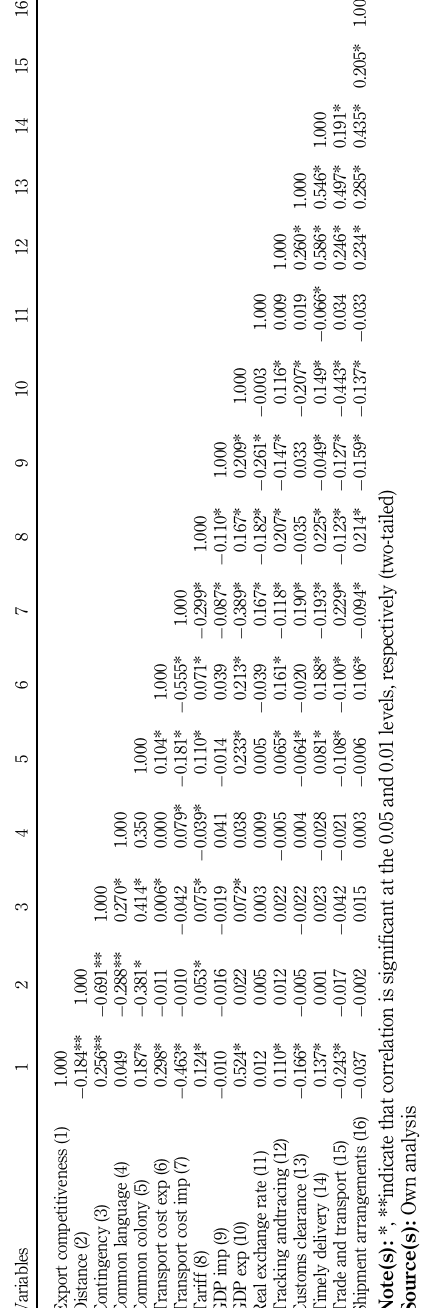
Table 5. Correlation